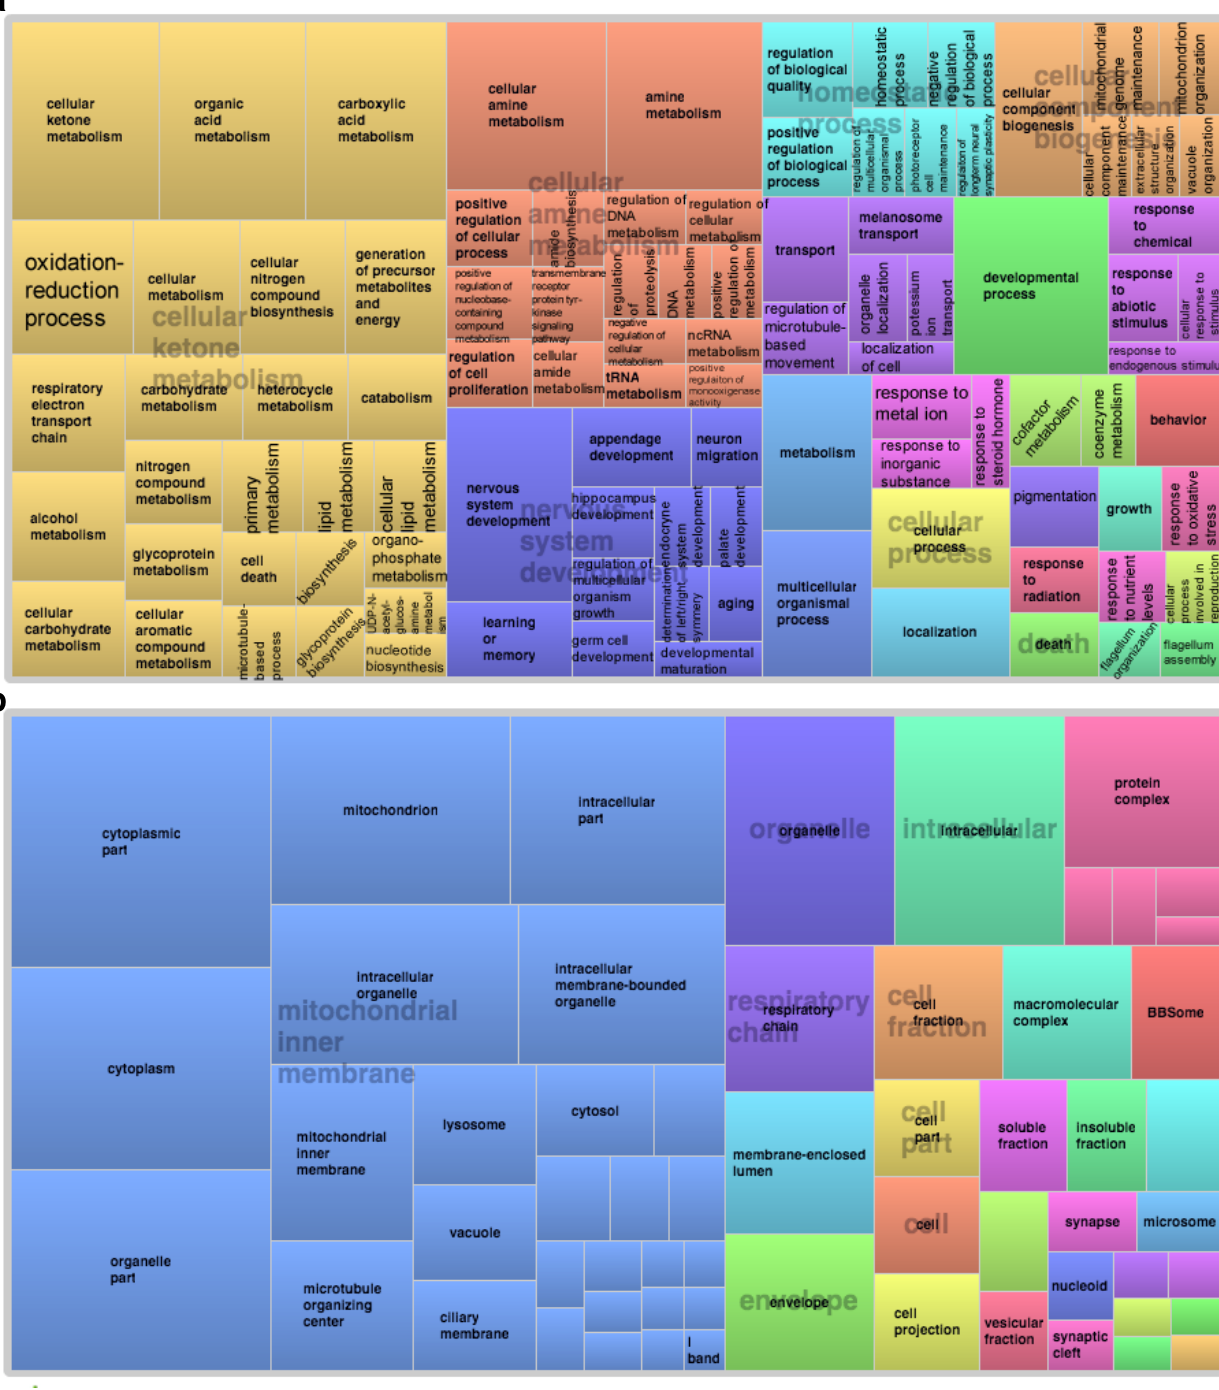
Figure 6. REViGO tree analysis of over-represented Gene Ontology terms obtained with DAVID and associated with the 818 intellectual disability genes. Panel ( a ) shows Biological Process terms and panel ( b ) shows Cellular Component terms. DAVID, Database for Annotation, Visualization, and Integrated Discovery; REViGO, Reduce + Visualize Gene